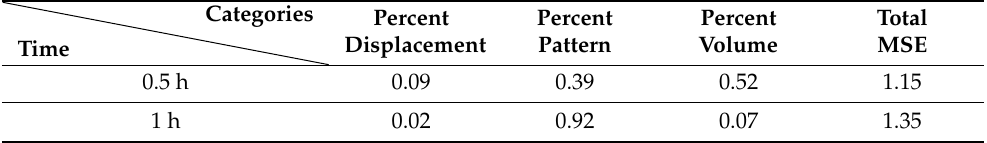
Table 9. Deep learning algorithm CRA